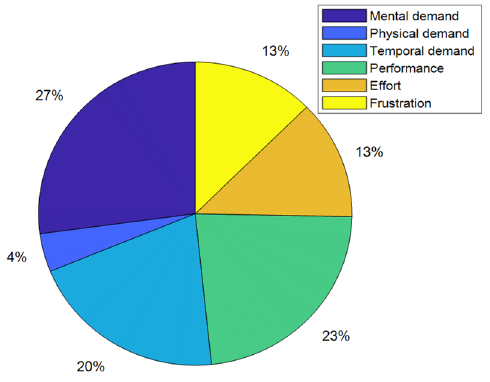
Figure 7. Weighting of each NASA-TLX scale in percent.